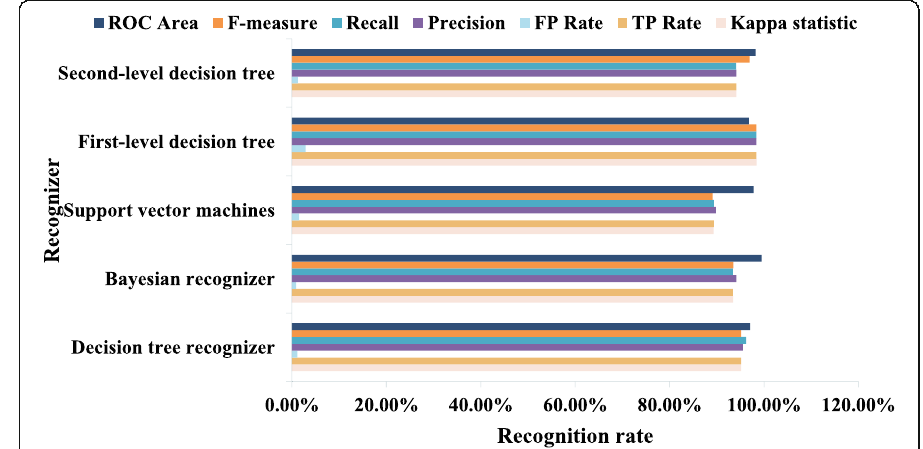
Fig. 4 Comparison of weighted average coefficients corresponding to different recognizers